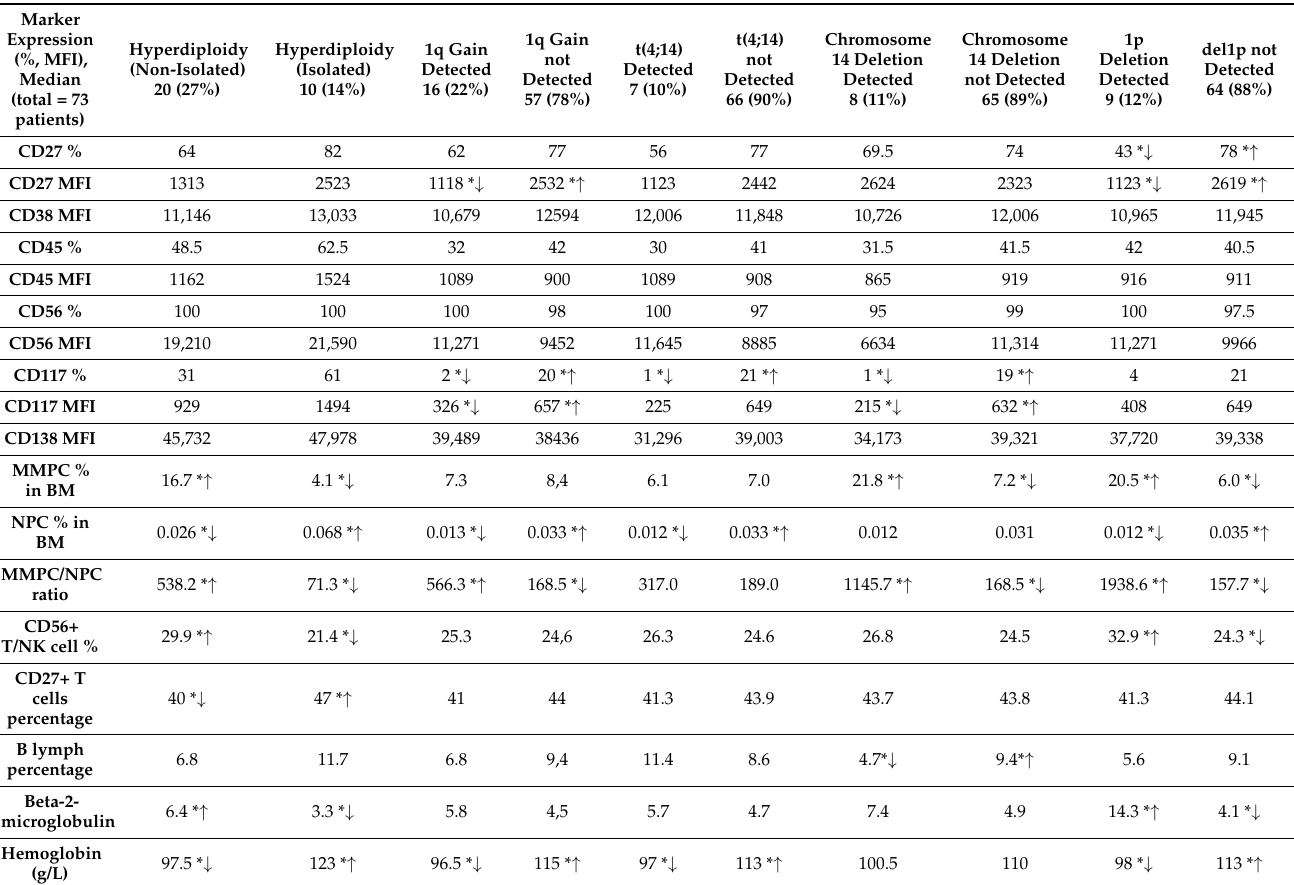
Table 2. Differences in immunophenotype (by MFI or percentage median), bone marrow cell percent- ages and laboratory test values between different genetic MMPC subgroups. MFI—mean fluores- cence intensity, MMPC—malignant plasma cells, NPC—normal plasma cells. Statistically significant ( p < 0.05) differences in bold and marked with *; arrow indicates if value is higher or lower than the contrary